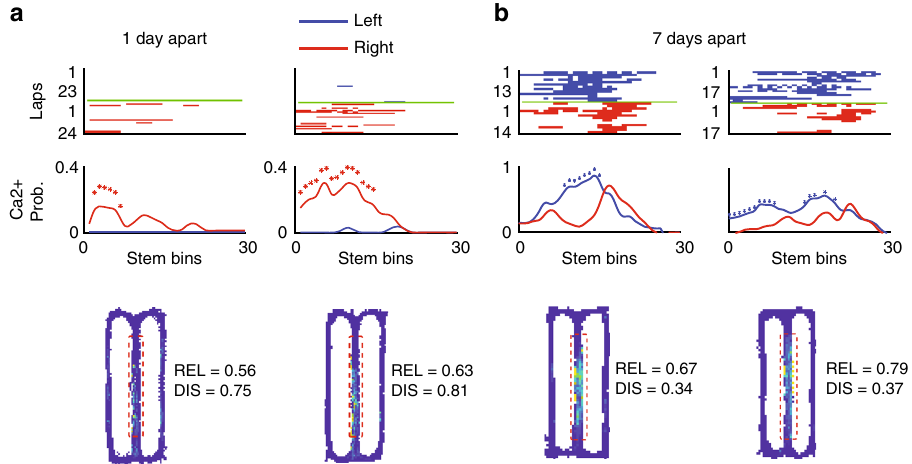
Fig. 2 Trajectory-dependent activity persists across days. a (top) Calcium event rasters along the stem for correct trials for two sessions recorded one day apart, sorted by turn direction at the end of the stem. Blue = left turns, Red = right turns. (middle) Calcium event probability curves for each turn direction. *indicates bins exhibiting signi fi cant trajectory-dependent activity ( p < 0.05, one-sided shuf fl e-test). Curves were smoothed using a smoothing spline for visualization purposes ( p = 0.9, see Methods). (bottom) occupancy normalized calcium event map with reliability (REL) and discriminability (DIS) scores shown. Blue = no calcium activity, yellow = maximum calcium activity, red dashed = extent of stem considered in above plots. b Same as a, but for a different mouse and for sessions 7 days apart.